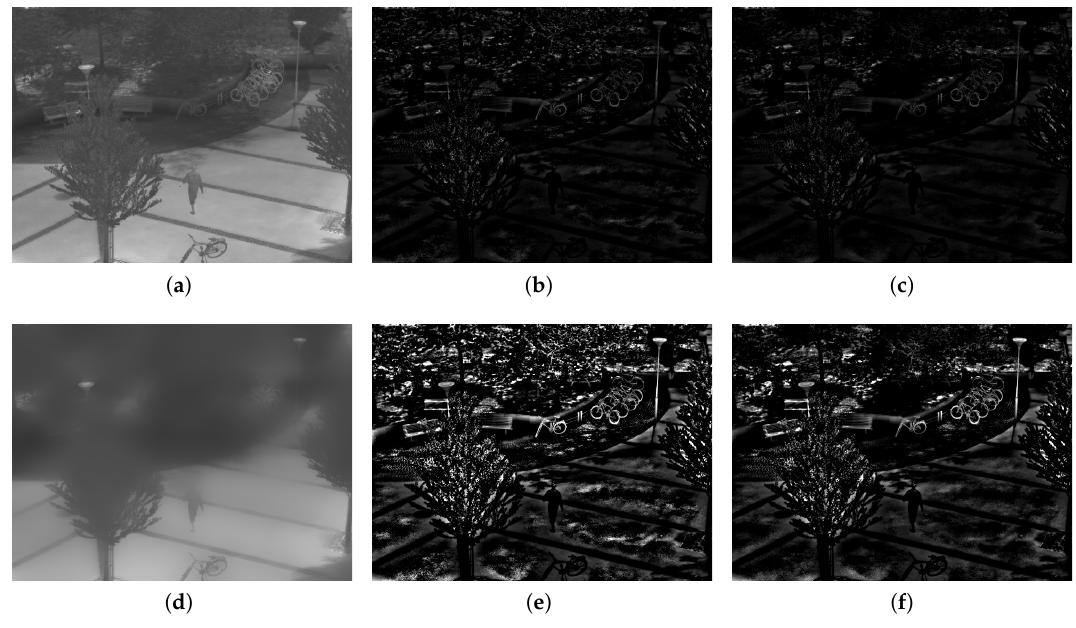
Figure 2. ( a ) Input Image. ( b ) Detail Layer 1. ( c ) Detail Layer 2. ( d ) Base Layer. ( e ) Enhanced Detail Layer 1. ( f ) Enhanced Detail Layer 1.